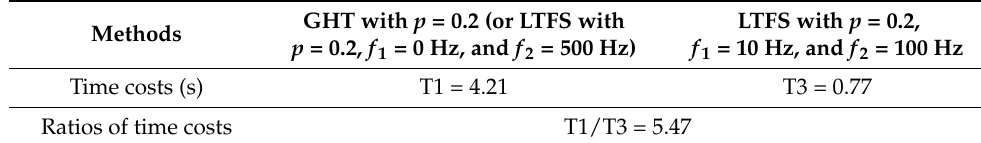
Table 1. Time costs of GHT and LTFS results in Figure